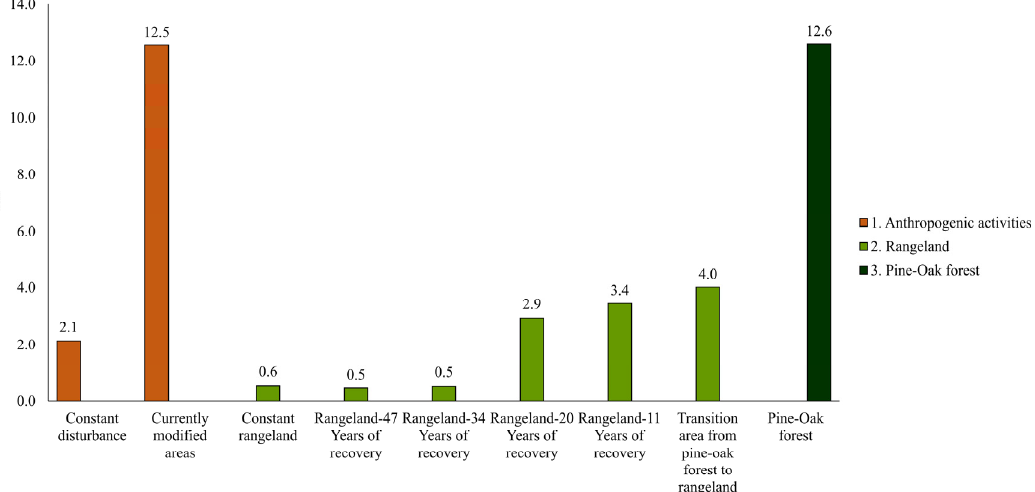
Figure 13. Represented area (km 2 ) for each category of land use coverage during the study period, La Peña, Miquihuana, Tamaulipas, Mexico.